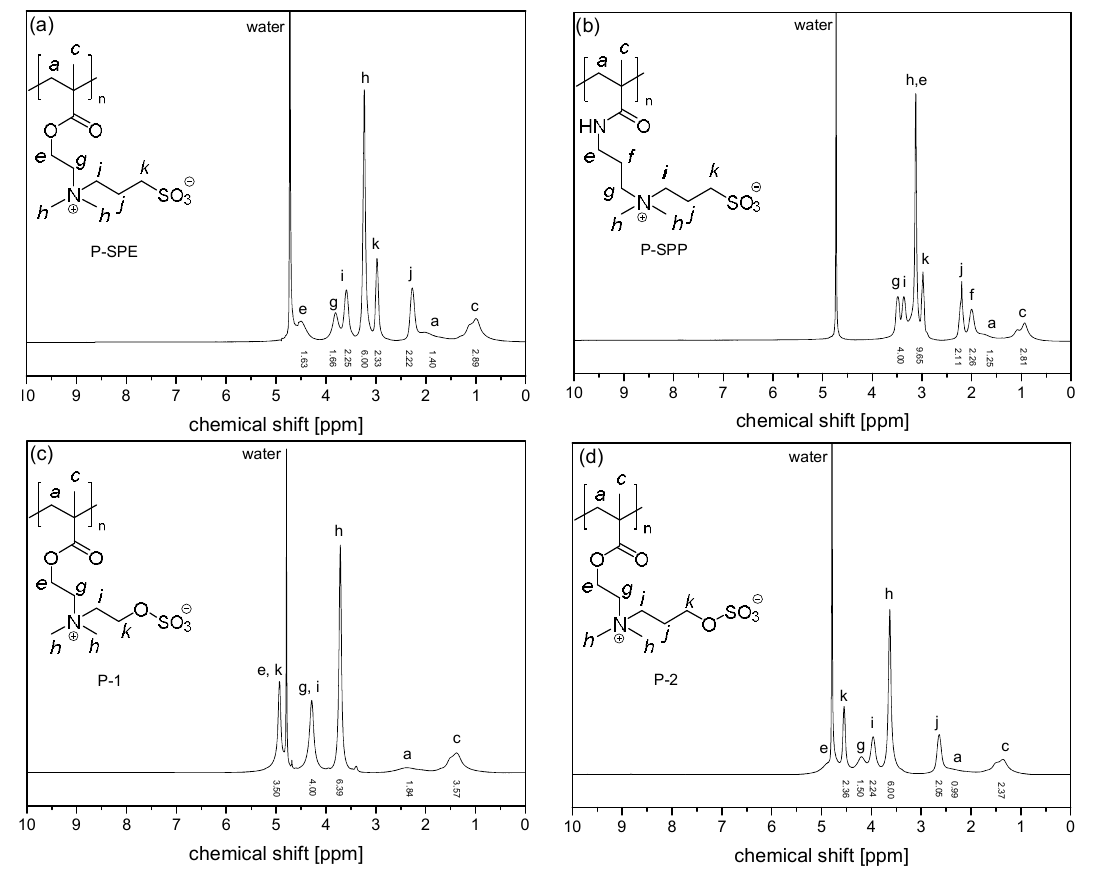
Figure 2. 1 H NMR spectra in D 2 O containing NaCl of ( a ) P-SPE (9.0 g · L − 1 NaCl), ( b ) P-SPP (9.0 g · L − 1 NaCl), ( c ) P-1 (saturated solution), and ( d ) P-2 (saturated solution).